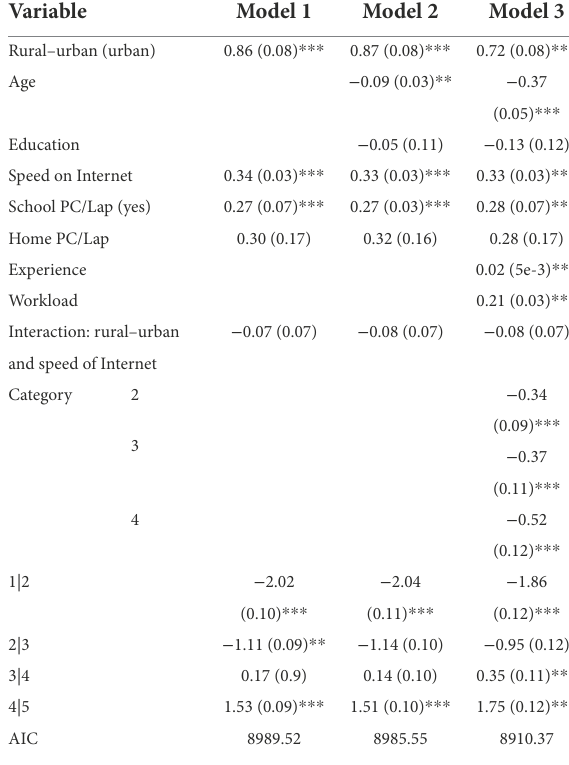
TABLE 4 Results of ordinal logistic regression models (centered solution, n = 3,029).